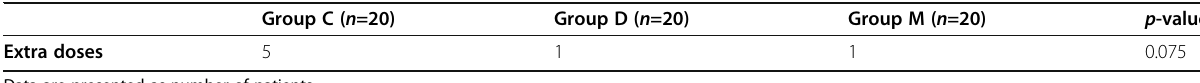
Table 3 Comparison between the three groups regarding the need for supplementary injections of the anesthetic